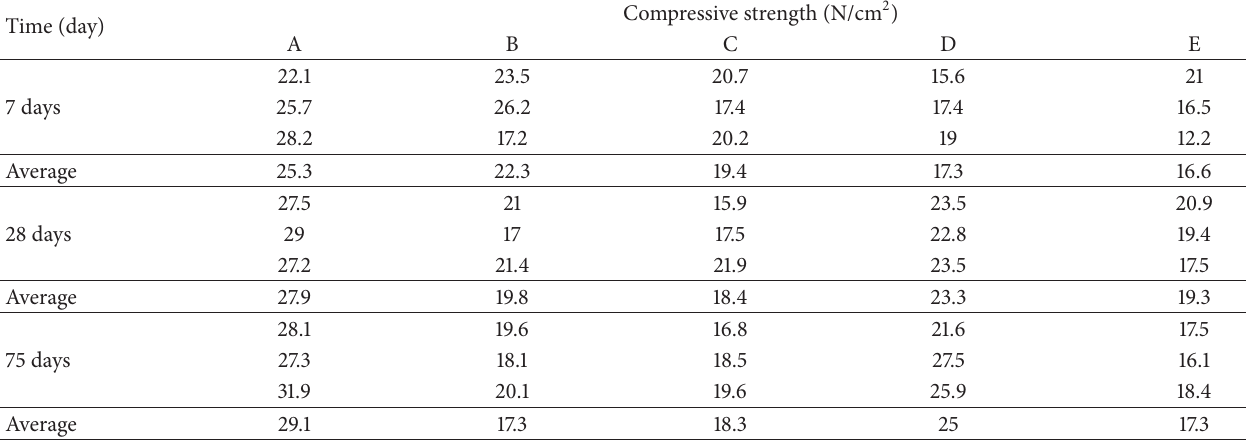
Table 5: Unconfined compression strength of soil specimens for groups with different ages.